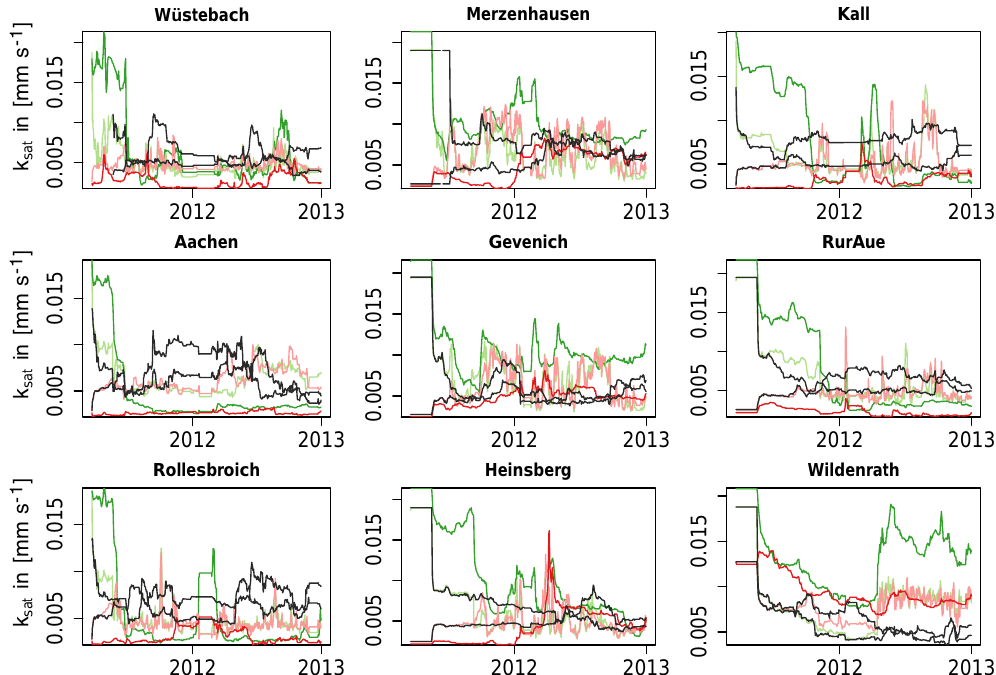
Figure 7. At nine sites, estimates of saturated hydraulic conductivity (top 15cm) are shown for simulations with parameter update: PAR- S80-30 (green), PAR-S80-10 (light green), PAR-BK50-30 (red), PAR-BK50-10 (light red), jk8-S80- ∗ (black) and jk8-BK50- ∗